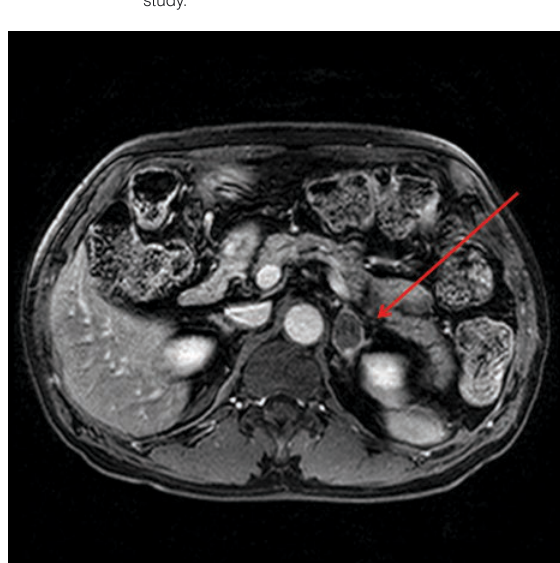
Figure 2. Magnetic resonance imaging showed no internal fatty component with peripheral enhancement in dynamic study.